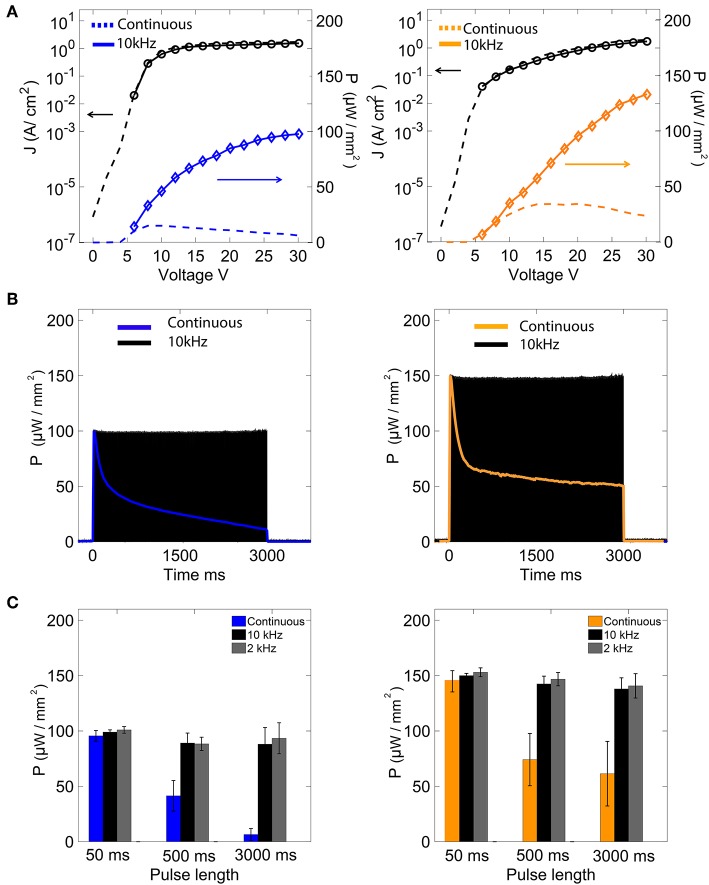
Performance characteristics of blue and orange OLEDs. (A) Current-density and optical power vs. voltage characteristics for blue and orange devices under DC and 10 kHz square-wave operation. (B) Optical output power vs. time for blue and orange OLEDs under DC and 10 KHz square-wave operation. (C) Peak optical power (mean ± sem) under DC and square-wave operation for measurement times of varying length.